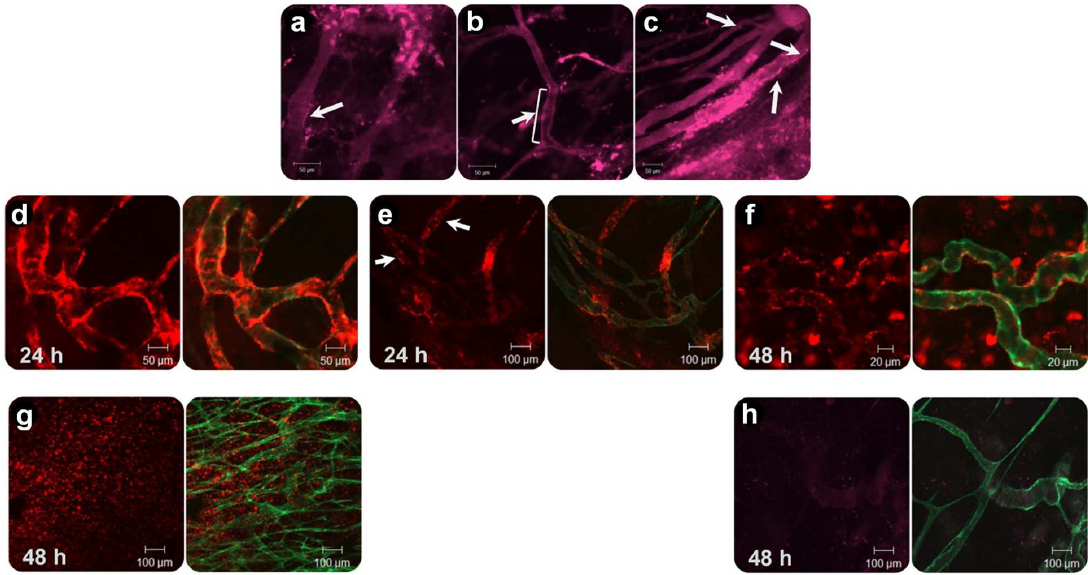
Figure 7. Intratumoral behavior of DiD-labeled RGDf[N-met]C-liposomes in NMRI nu/nu mice bearing BLM tumor ( a – c ), and Rho-PE-labeled (red) RGDf[N-met]C-liposomes in C57 mice bearing B16F0 tumor ( d – g ) imaged by intravital microscopy, using dorsal skin-fold chamber. Panel ( h ) illustrates the intratumoral behavior of DiD-labeled (purple) plain liposomes. RGDf[N-met]C-liposomes were found to be associated with the tumor vasculature (arrows in a – f ) or extravasated and associated with tumor cells and likely other cells in the tumor region ( g ). Meanwhile, few plain liposomes were found associated with cells inside or outside the tumor vasculatures. Reprinted with permission from [29].